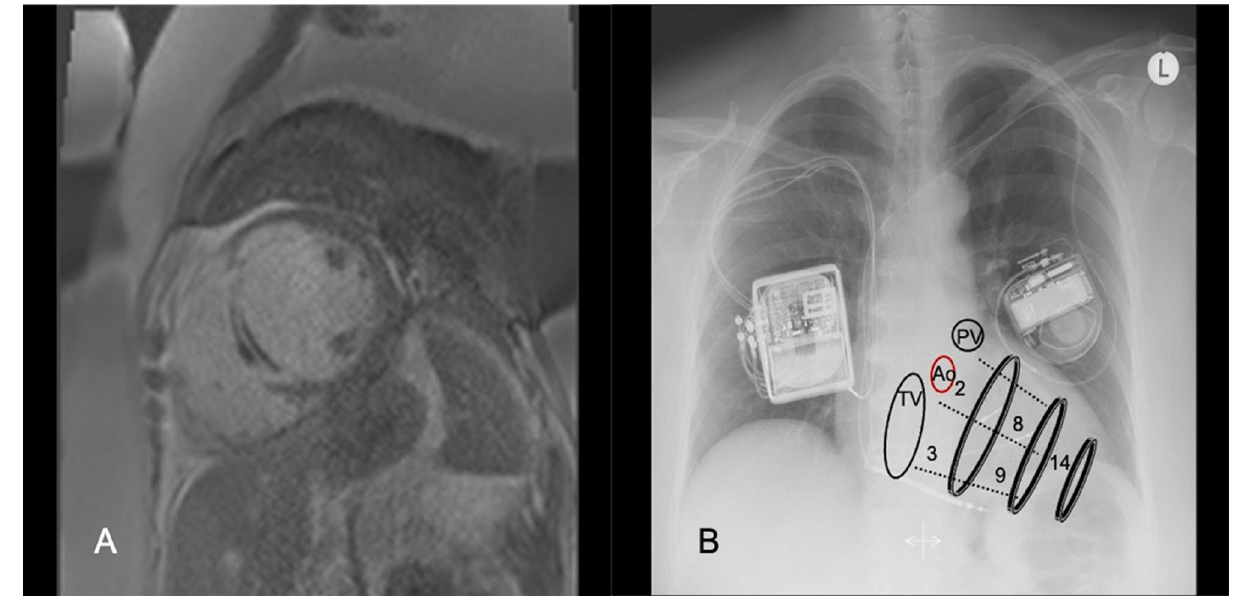
Figure 1. CCM implantation and placement of leads according to AHA segment model. ( A ) septal LGE in Segment 8 (LGE > 25%), ( B ) position of CCM leads at septum according to AHA-segment